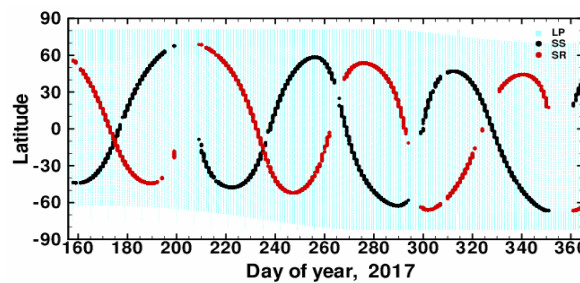
Figure 9. SAGE III/ISS solar occultation coverage compared to OMPS/LP coverage. Red: sunrises; black: sunsets; light blue: